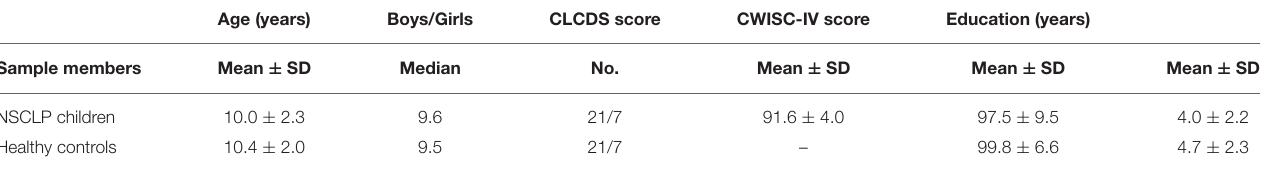
TABLE 1 | Demographic and clinical